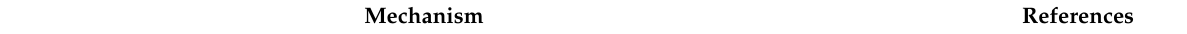
Table 1. Proposed mechanisms of macrovoids formation in the literature.